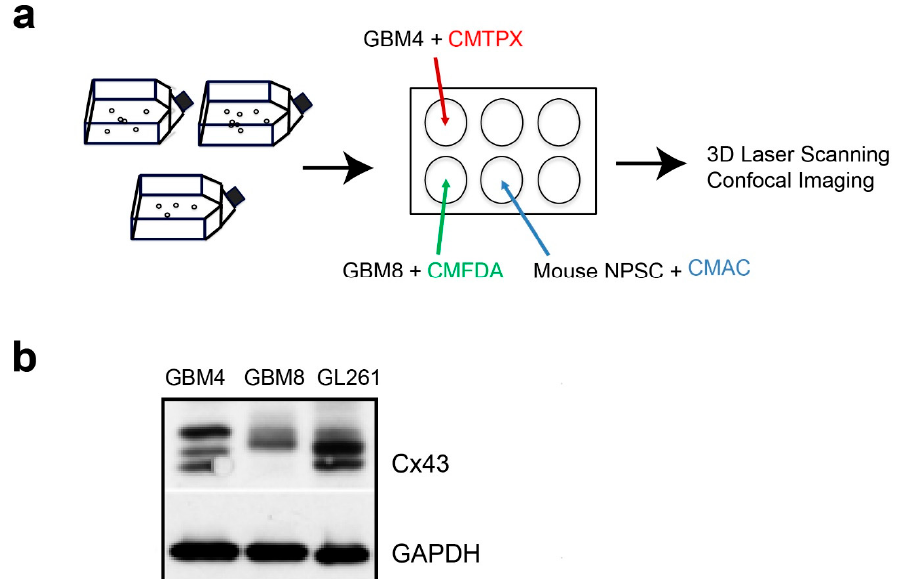
Figure 1. Cx43 protein is expressed in human brain tumor-initiating cells GBM4 and GBM8. ( a ) Schematic diagram illustrating the culture and labeling of spheroids with cell-tracker dyes (CMTPX, CMFDA and CMAC) to distinguish them for live imaging by confocal microscopy. ( b ) Western analysis of cell lysates of GBM4 and GBM8 with anti-Cx43 antibody showing multiple protein bands corresponding to di ff erent phosphorylated isoforms. Cx43 species in mouse GL261 glioma cells used in our intracranial mouse implantation [15] was included as a comparison. GAPDH was used as loading